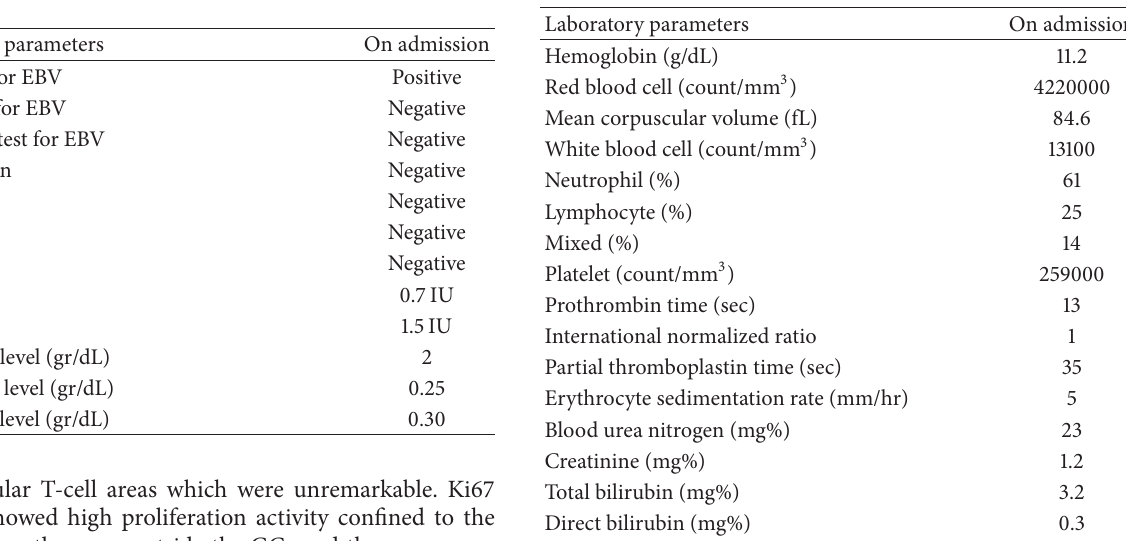
Table 2: Results of hematologic